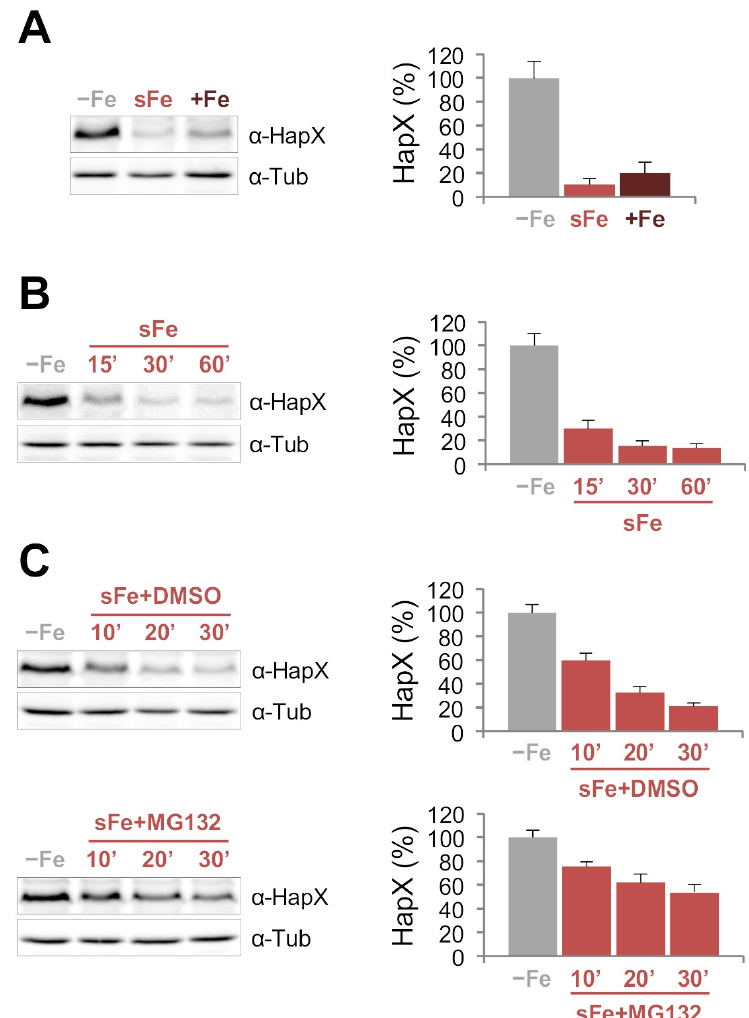
Figure 2. HapX is rapidly degraded during the adaptation from iron-depleted to iron-replete con- ditions in a proteasome dependent manner . ( A – C ). HapX quantification by Western blot analysis. Samples were obtained from the wild-type strain grown at 37 ◦ C in liquid Aspergillus Minimal Medium (AMM) − Fe (20 h in iron depletion), sFe (20 h in iron depletion and then supplemented with 10 µ M FeSO 4 for 1 h) and +Fe (20 h in 30 µ M FeSO 4 ) ( A ); grown at 37 ◦ C in AMM − Fe and sFe for 15, 30 and 60 min ( B ); or grown at 37 ◦ C in AMM − Fe and sFe for 10, 20 and 30 min with or without 50 µ M MG132, dissolved in DMSO ( C ). Left panels: Representative Western blot analysis showing HapX protein levels. α -Tubulin was used as loading control. Right panels: Densitometric protein quantification. HapX protein levels were normalized to Tubulin and expressed relative to those in − Fe. Bars represent standard deviations from two independent biological experiments with two technical replicates